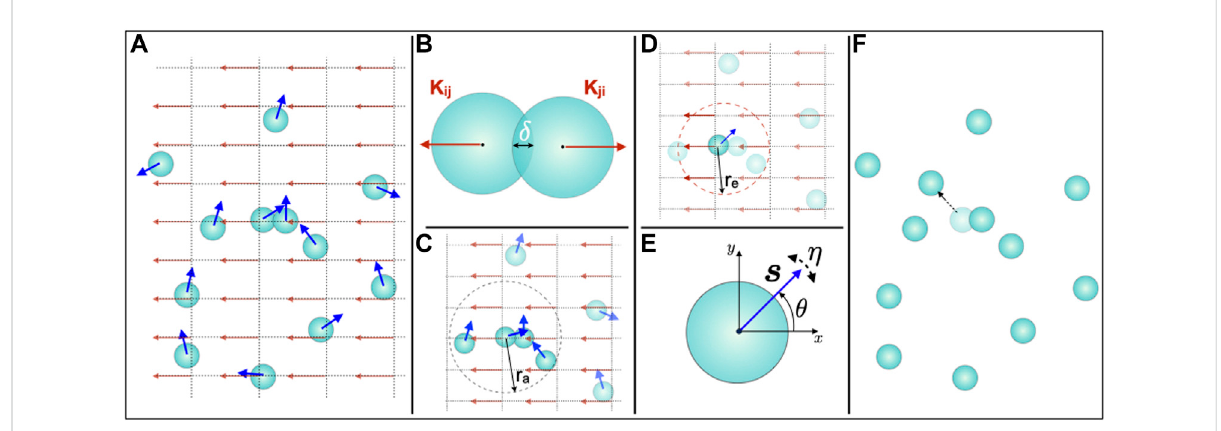
FIGURE 2 Computational model for osteoblast cell migration in an external DC electric fi eld. (A) Osteoblasts in the cell culture chamber exposed to the DCelectric fi eldaremodelledasactiveparticles(lightbluecoloureddisks)ofradius R ,and,theirmotionatanytime t isdescribedbythevelocity v t i ( i is theindexofthecell).Thedarkbluecoloredarrowslaidoverthecirculardisksaretheunitvectors s t i ofthecellvelocitywiththemagnitude v 0 attime t . The model takes into account both cell-cell and cell-electric fi eld interactions. These interactions can in fl uence the cell velocity.